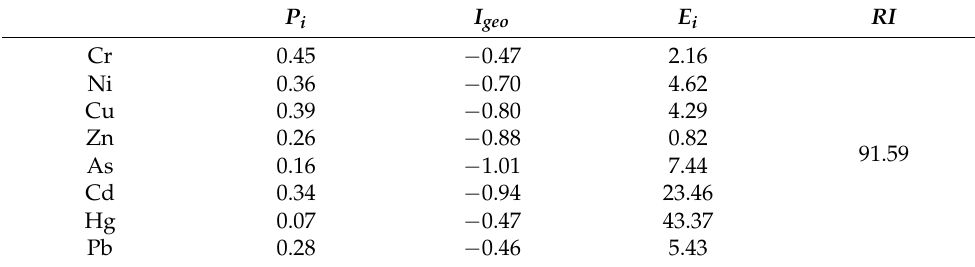
Table 9. Values of P i , I geo , E i , and RI